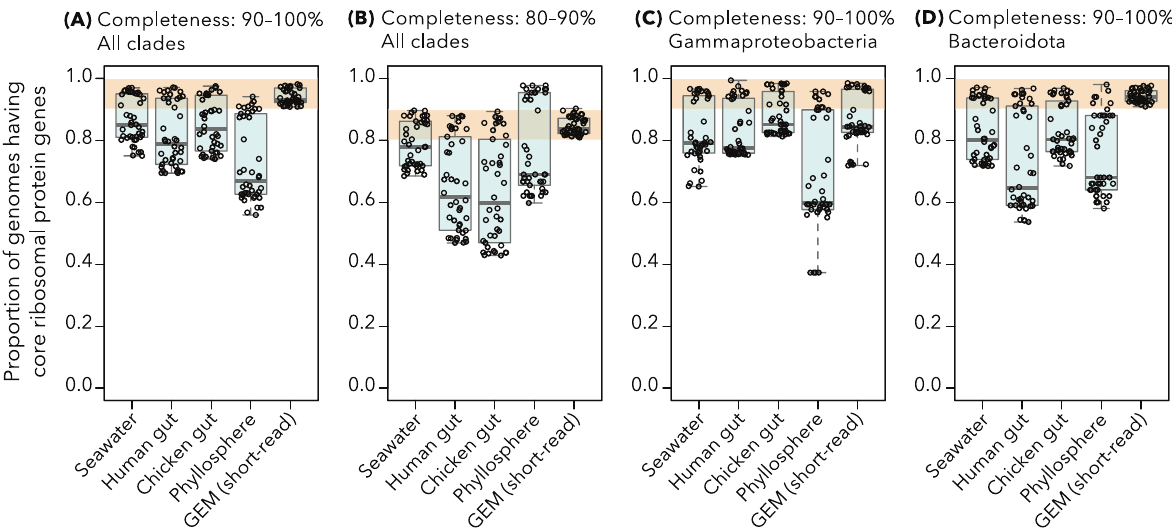
Fig. 1 Proportion of MAGs harboring each ribosomal protein ortholog from fi ve MAG datasets reconstructed using only short-read sequences. Each point represents one ribosomal protein ortholog (listed in Supplementary Table S1). Lines within each box and whiskers indicate three quartiles and the maximum/minimum values, respectively. Orange bands indicate the value ranges that could be expected from completeness of MAGs. Panels A and B show the results for all the bacterial MAGs with 90 – 100% and 80 – 90% completeness, respectively. Panels C and D show the results of MAGs with 90 – 100% completeness classi fi ed as class Gammaproteobacteria and phylum Bacteroidota, respectively. The de fi nition of each phylum/class is slightly inconsistent between the fi ve sets of MAGs because different versions of the GTDB were used for taxonomic annotations (Table